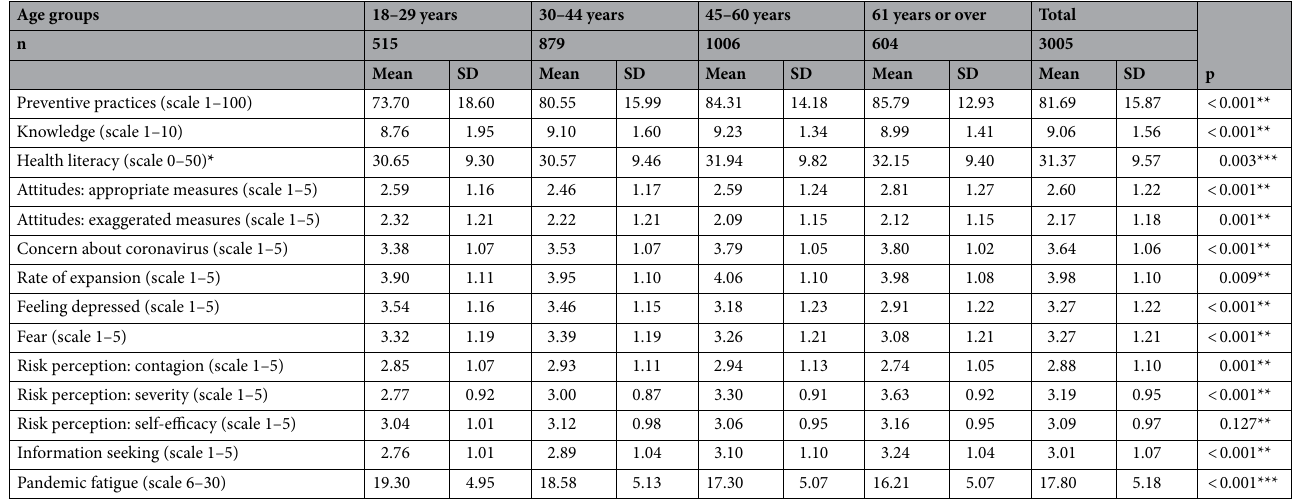
Table 4. Main variables by age groups. *For the Health literacy variable the n is 396 (18–29 years), 732 (30–44 years), 838 (45–60 years), 504 (61 years and older), 2470 (total). **Kruskal Wallis Test. All p-values are two-sided. ***ANOVA Test. All p-values are two-sided.